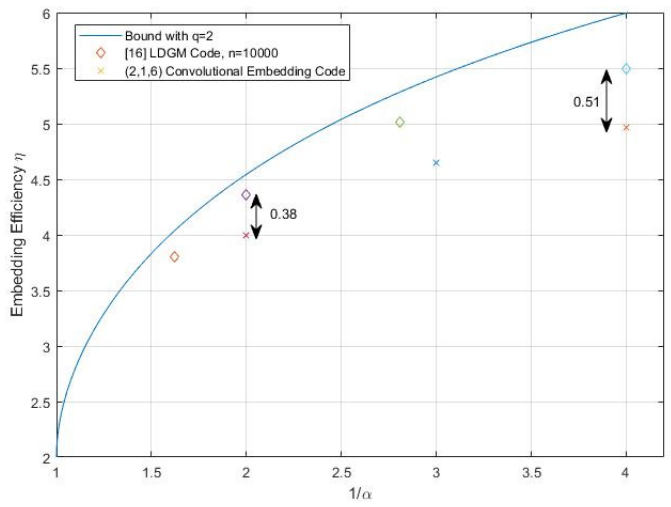
Figure 14. The embedding efficiency between [16] and convolutional embedding codes.